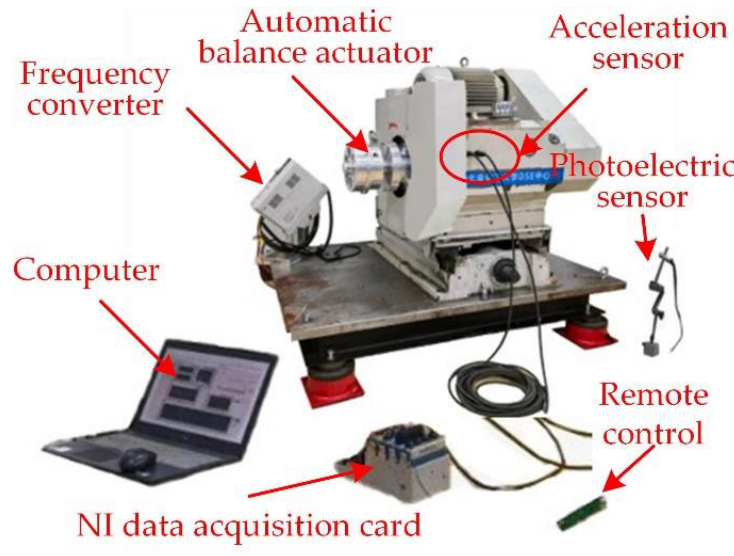
Figure 16. Overall structure drawing of the test device.